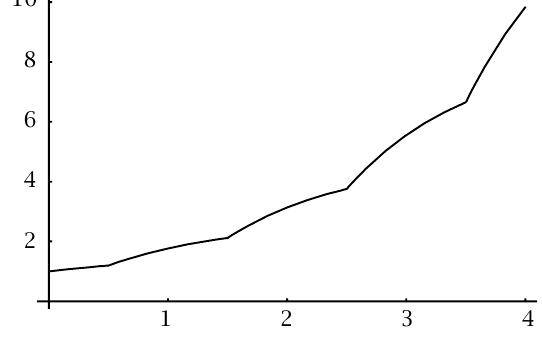
Figure 3.3 . T j (t) for b(t) = b , b = 3, j = 1, a = 1 /π